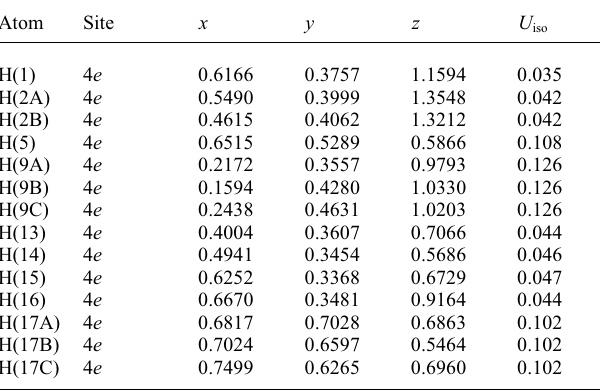
Table 2. Atomic coordinates and displacement parameters (in Å 2 )